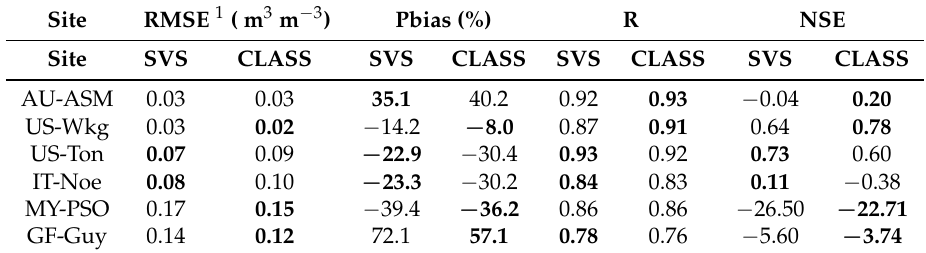
Figure 8. Precipitation (P) and soil water content (SWC) at 30-min sampling intervals for the MY-PSO tropical site: ( a ) precipitation; ( b ) soil water content at the surface layer (0–10 cm) for observations (black lines), SVS simulations (blue line) and CLASS simulations (red line); and simulated soil water content profile for ( c ) SVS and ( d ) CLASS models. Table 5. Scores between observations and simulations (SVS and CLASS) of the surface water content for all the study sites. The scores were obtained for 30-min sampling intervals. The bold numbers correspond to the best